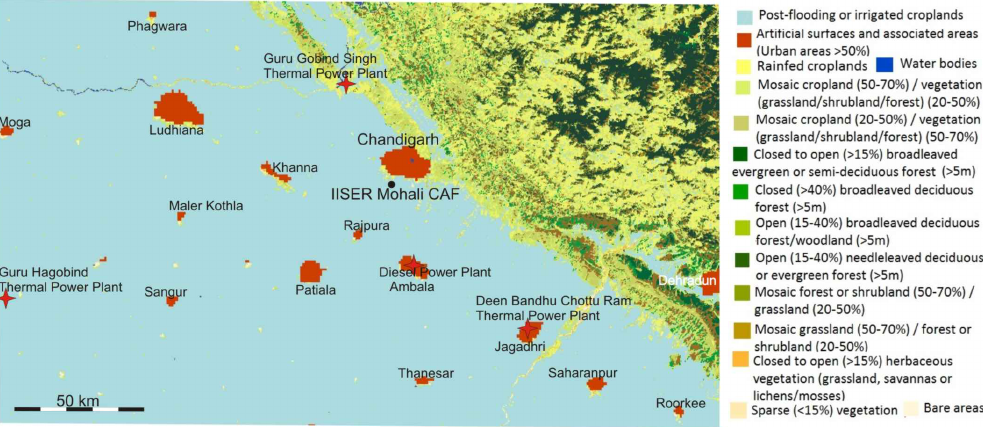
Figure 3. Map of the land classification (courtesy ESA GlobCover 2009 Project) in a 100km × 200km area surrounding the measurement site (black